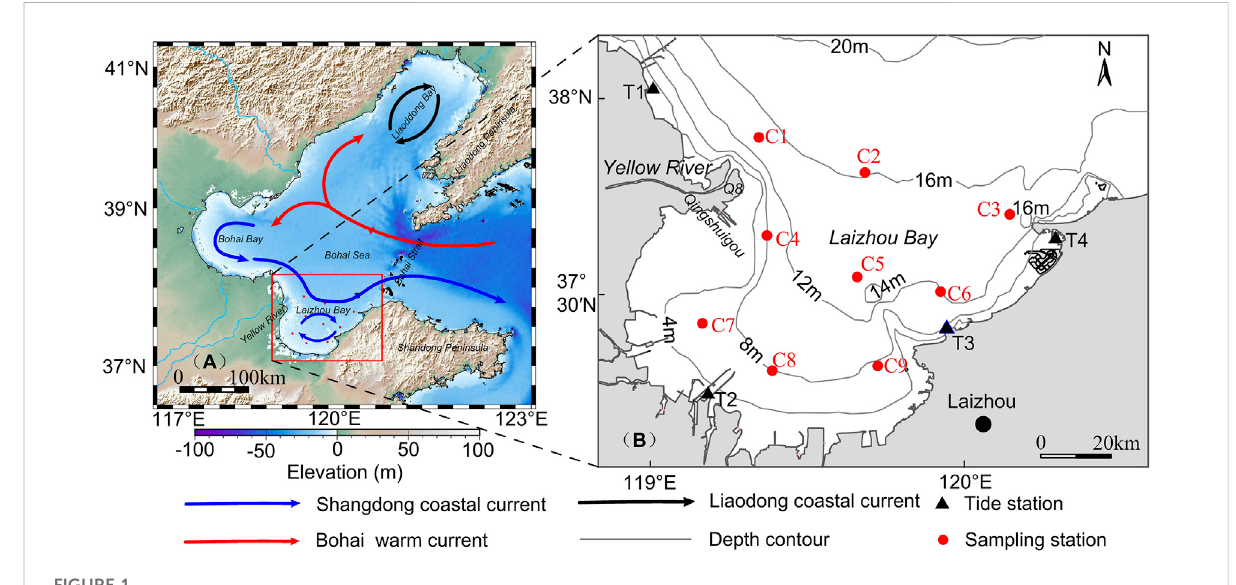
FIGURE 1 (A) Map of the study area (red open box) in the Bohai Sea. The elevation (+) over land and water depth (-) in the ocean are also shown (adapted fromFangetal.(2000)).BluearrowsrepresenttheShangdongcoastalcurrent.RedarrowsrepresenttheBohaiwarmcurrent.Blackarrowsrepresent the Liaodong coastal current (B) The red solid circle represents the sampling stations. The black solid triangles represent the tide stations. Gray lines represent